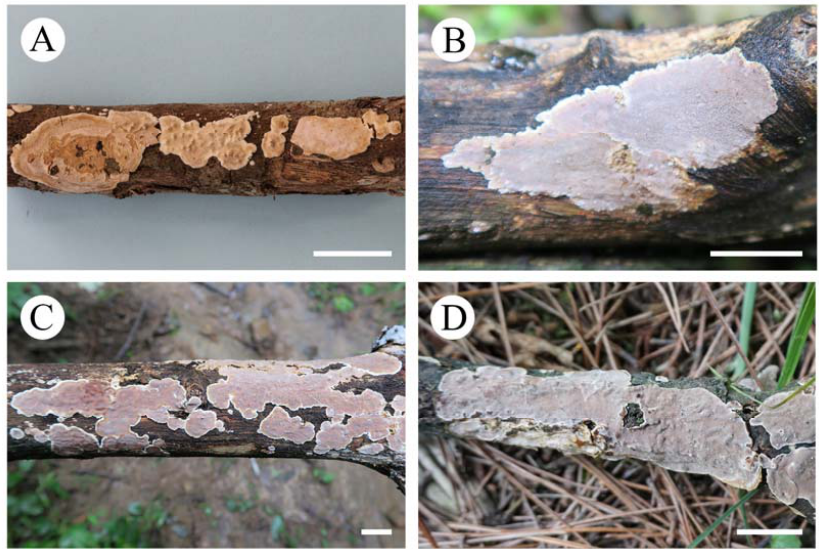
Figure 11. Basidiomes of Eichleriella species. Scale bars: ( A–D ) = 1 cm. ( A ). E. delicata (He 3469, BJFC 021866); ( B ). E. discolor (He 4763, BJFC 024281); ( C ). E. sinensis (He 4185, BJFC 023627); ( D ). E. sinensis (He 5392, BJFC